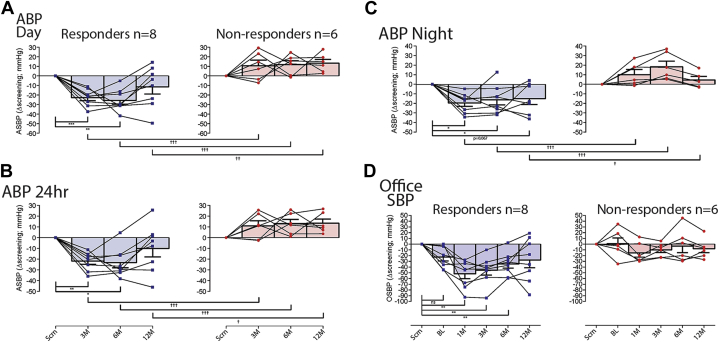
Blood Pressure Data for Responders (n = 8) and Nonresponders (n = 6) as Defined by ≥10 mm Hg Reduction in ABP at 3-Month Follow-UpASBP during day (A), night (B), and 24-h average (C) at 3-, 6-, and 12-month follow-ups (represented as change from screening). (D) OSBP response at screening, baseline, and at 1-, 3-, 6-, and 12-month follow-ups (represented as change from screening). Two-way repeated measures analysis of variance was used (within groups *p < 0.05, **p < 0.01, ***p < 0.001; between groups †p < 0.05, ††p < 0.01, †††p < 0.01). Abbreviations as in Figure 2.